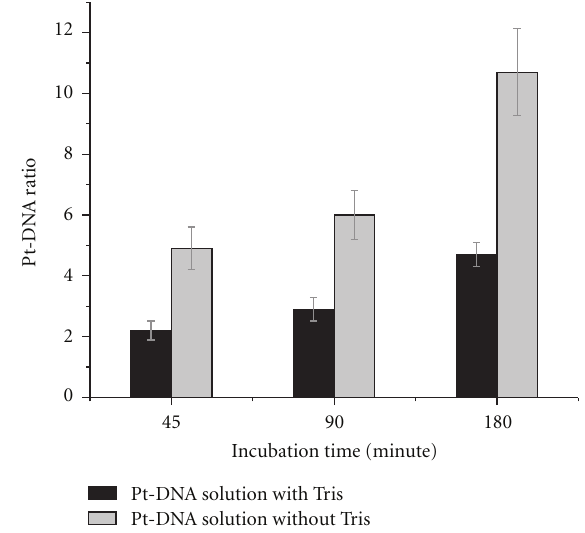
Figure 3: Impact of tris on the reaction of DNA platination. Pt- DNA ratios in the cisplatin-DNA solutions incubated during 45, 90, and 180 minutes at 25 ◦ C are compared in the presence and absence of tris. Data are means from three measurements; error bars show standard